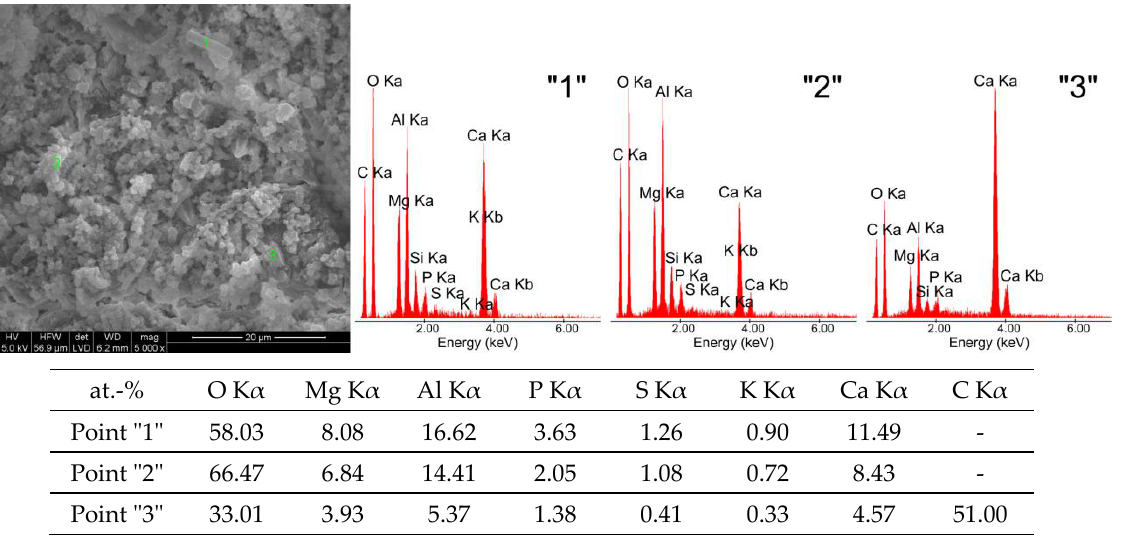
Figure 4. SEM microphotograph of tricalcium aluminate after exposure to pig slurry (G) and EDS quantitative point analyses of areas 1, 2, 3.